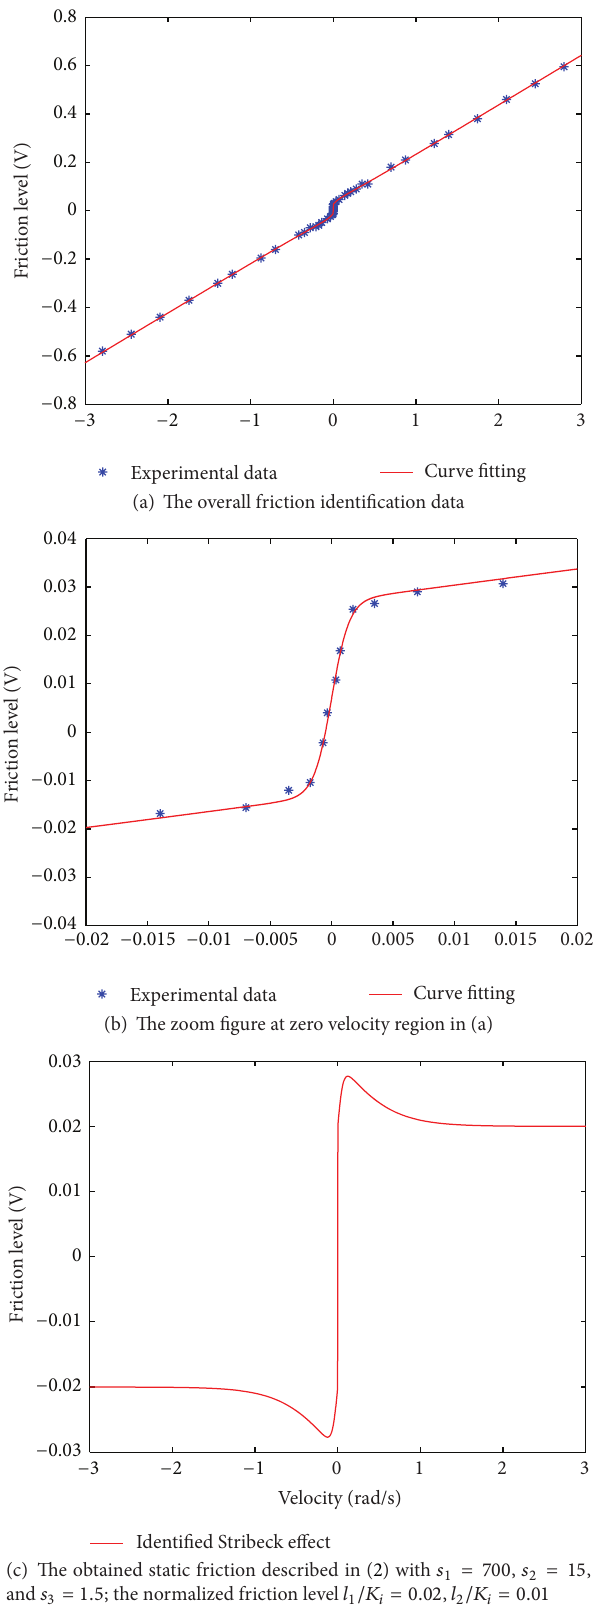
Figure 3: Experimental results and curve fitting of nonlinear